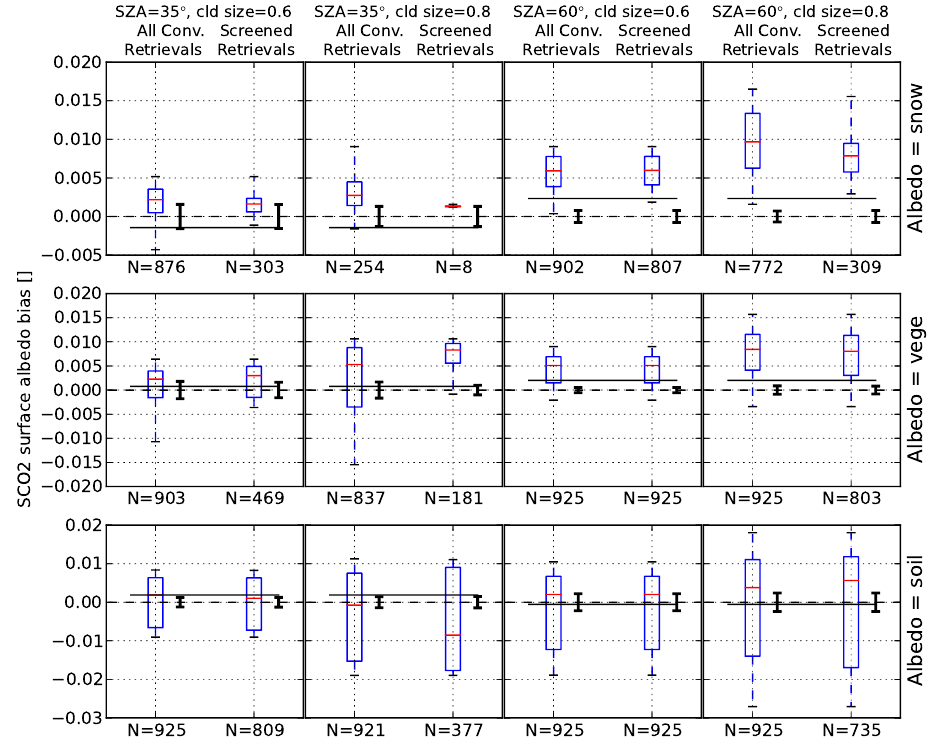
Figure 10. Summary of SCO2 surface albedo retrieval bias for all scenarios with 0.6 and 0.8 km clouds, with the same layout as Fig. 8. Figure 11. Bias in retrieved surface pressure, with the same layout as Fig.